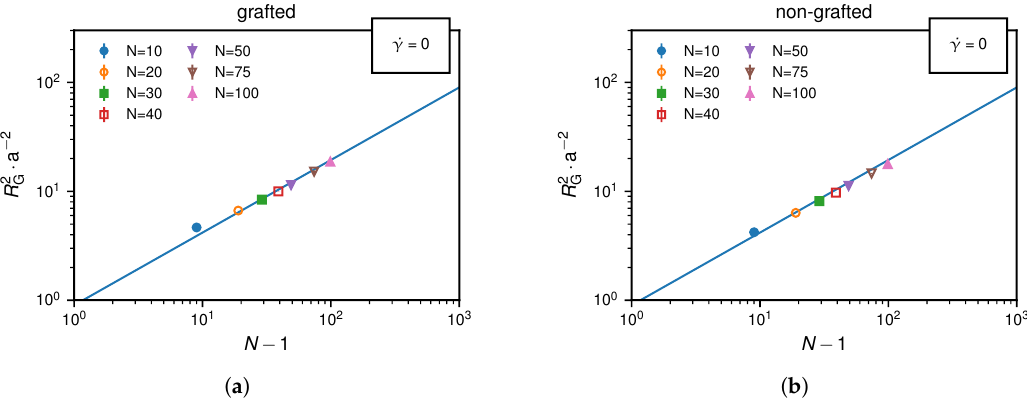
Figure 3. Equilibrium results for zero shear rate ( ˙ γ = 0 ) : The mean-squared radius of gyration, R 2 as function of the monomer number, N − 1, is described by the expected scaling law for collapsed ∼ ( N − 1 ) 2/3 , shown as a blue line both in ( a ) the grafted and ( b ) the non-grafted polymers, R 2 G